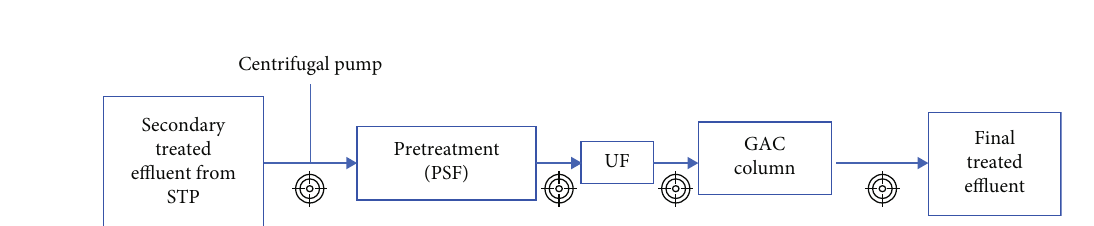
Figure 3: Treatment con fi guration 3.